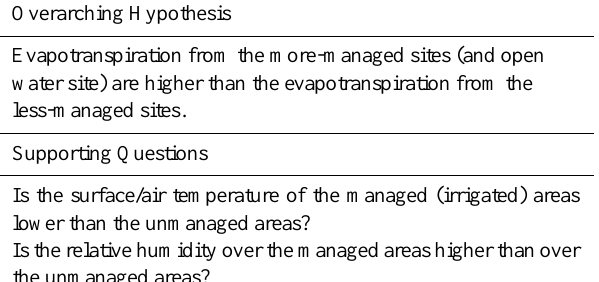
Table 3. The overarching hypothesis and several supporting ques- tions developed and answered by students in the course Ecohydrol- ogy: A Mediterranean perspective